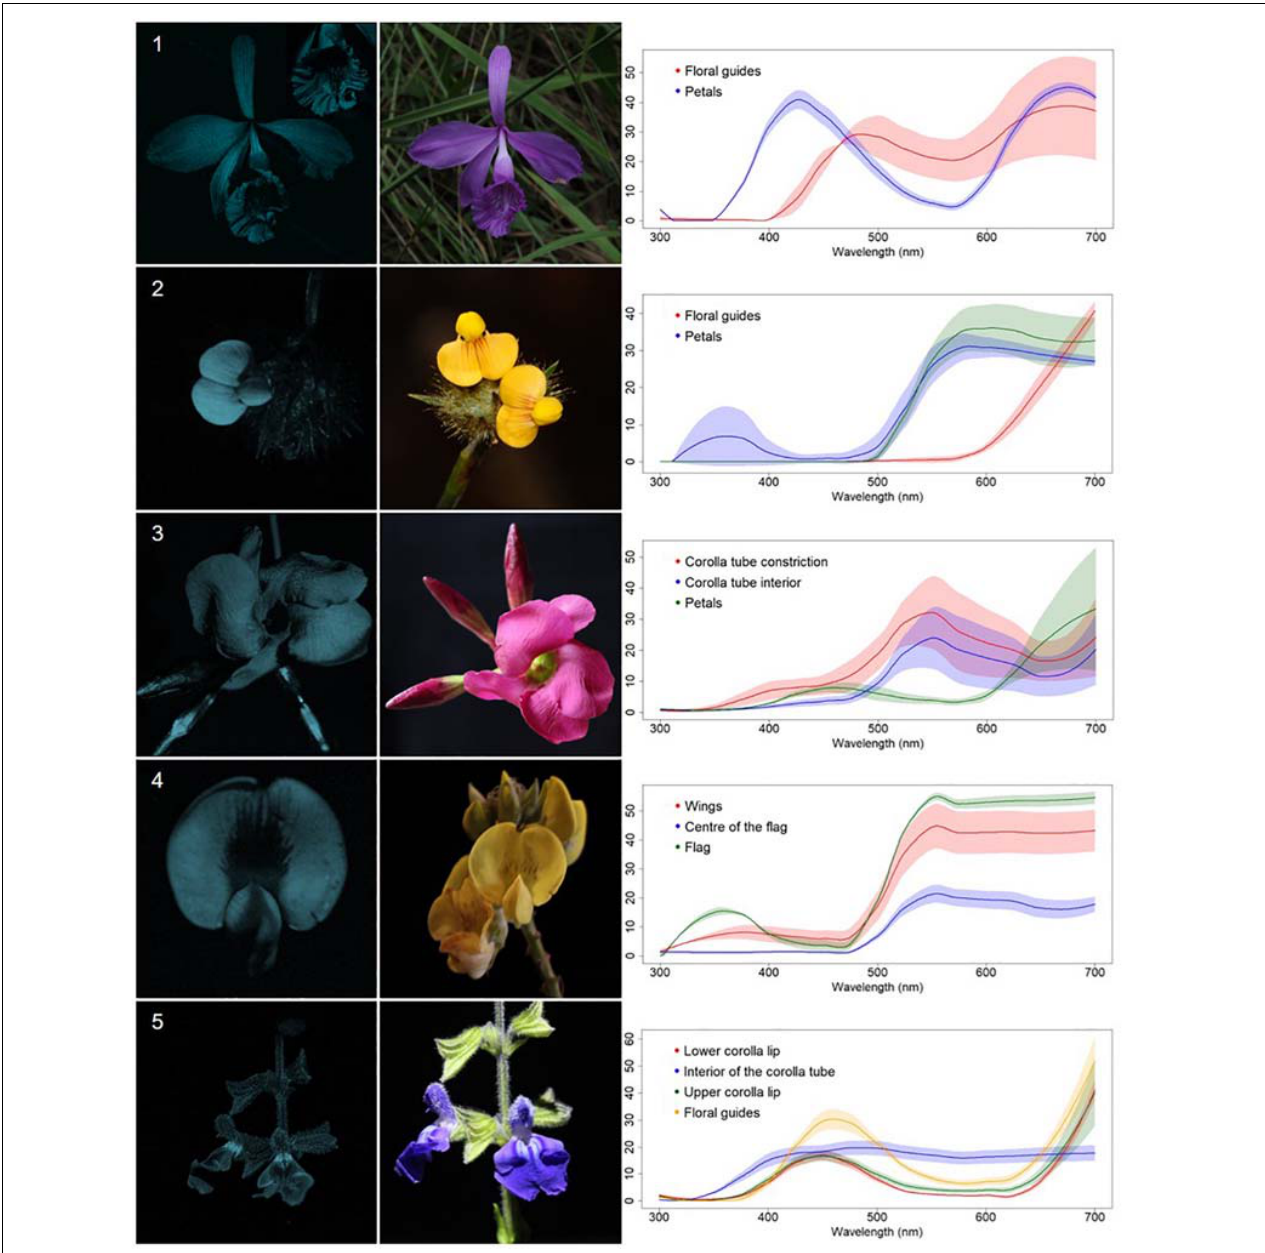
FIGURE 4 | Contrasting corolla markings oriented towards floral resources UV-patterned flowers (CM) from a Neotropical savanna community. Each row comprises information of one species. First column: UV-photography. Second column: flower as seen by the human eye (conventional photography). Third column: reflectance curves of different portions of the flowers. Row 1. Epistephium sclerophyllum Lindl. (Orchidaceae). Row 2. Stylosanthes guianensis (Aubl.) Sw. (Leguminosae). Row 3. Temnadenia violacea (Vell.) Miers (Apocynaceae). Row 4. Crotalaria micans Link (Leguminosae). Row 5. Salvia minarum Briq.